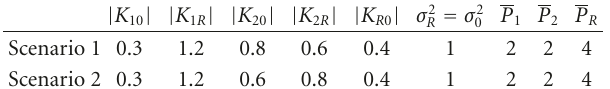
Table 1: Parameters of the two-user channel models used in the numerical results.